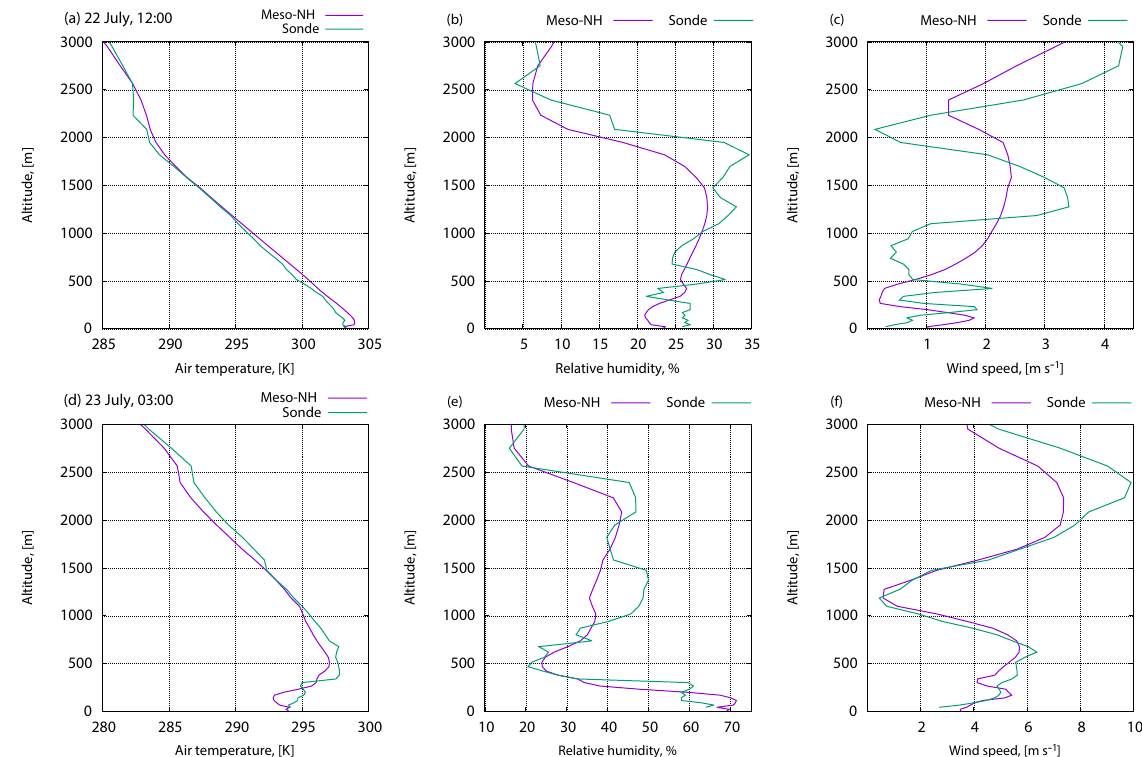
Figure 4. Profiles of air temperature, relative humidity, and wind speed in low atmosphere on 22 July at 12:00UTC and 23 July at 03:00UTC.